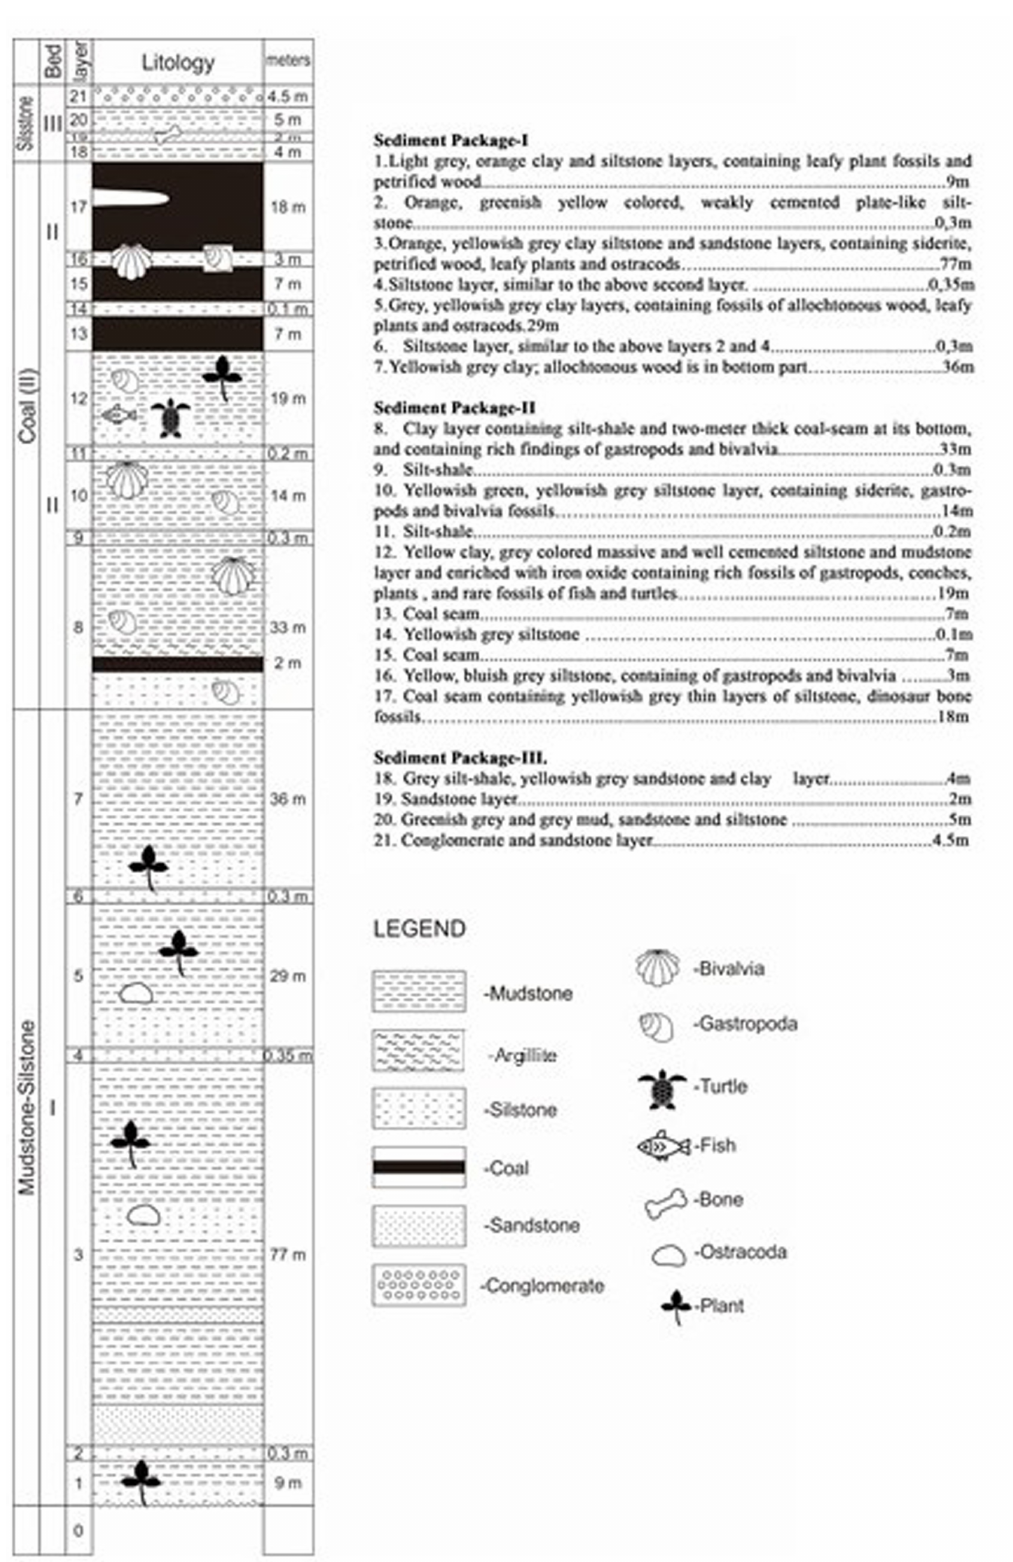
Fig. 3. Section of Lower Cretaceous sediments in the Ergel-Khaliv